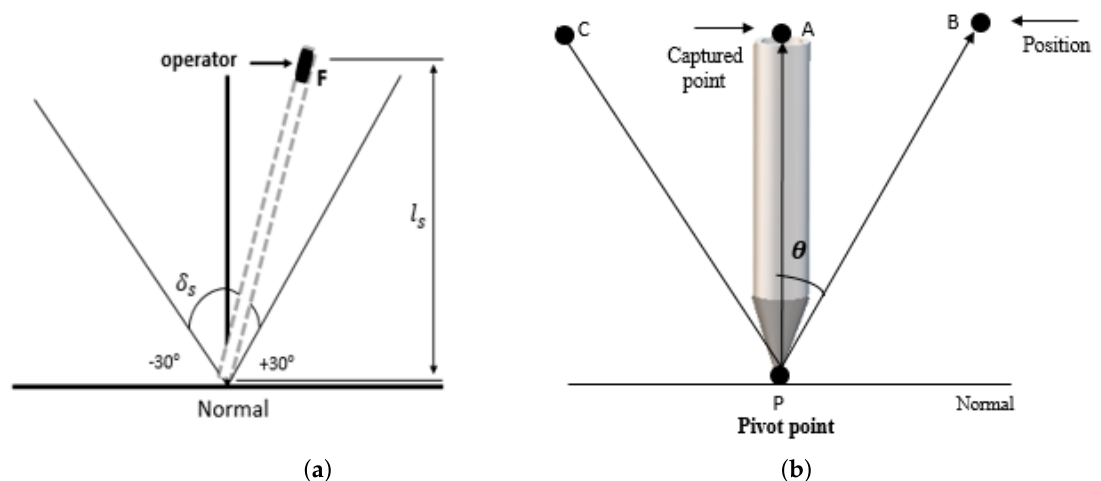
Figure 6. ( a ) Control stick acceptable range, ( b ) restriction mechanism for limiting haptic device to 1 DOF.